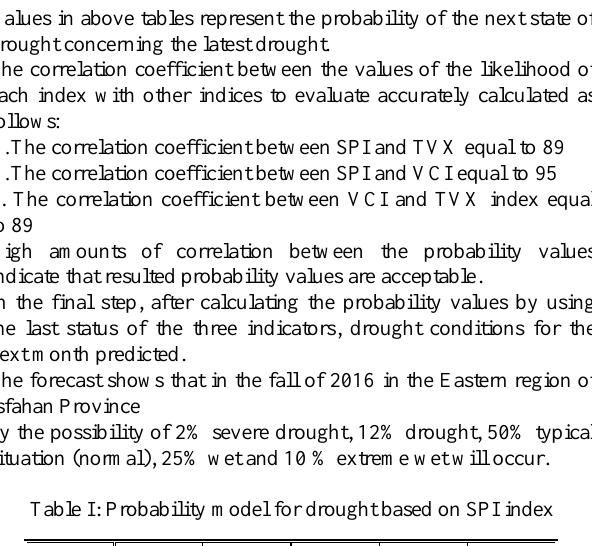
Figure 5: SAX presentation for drought index